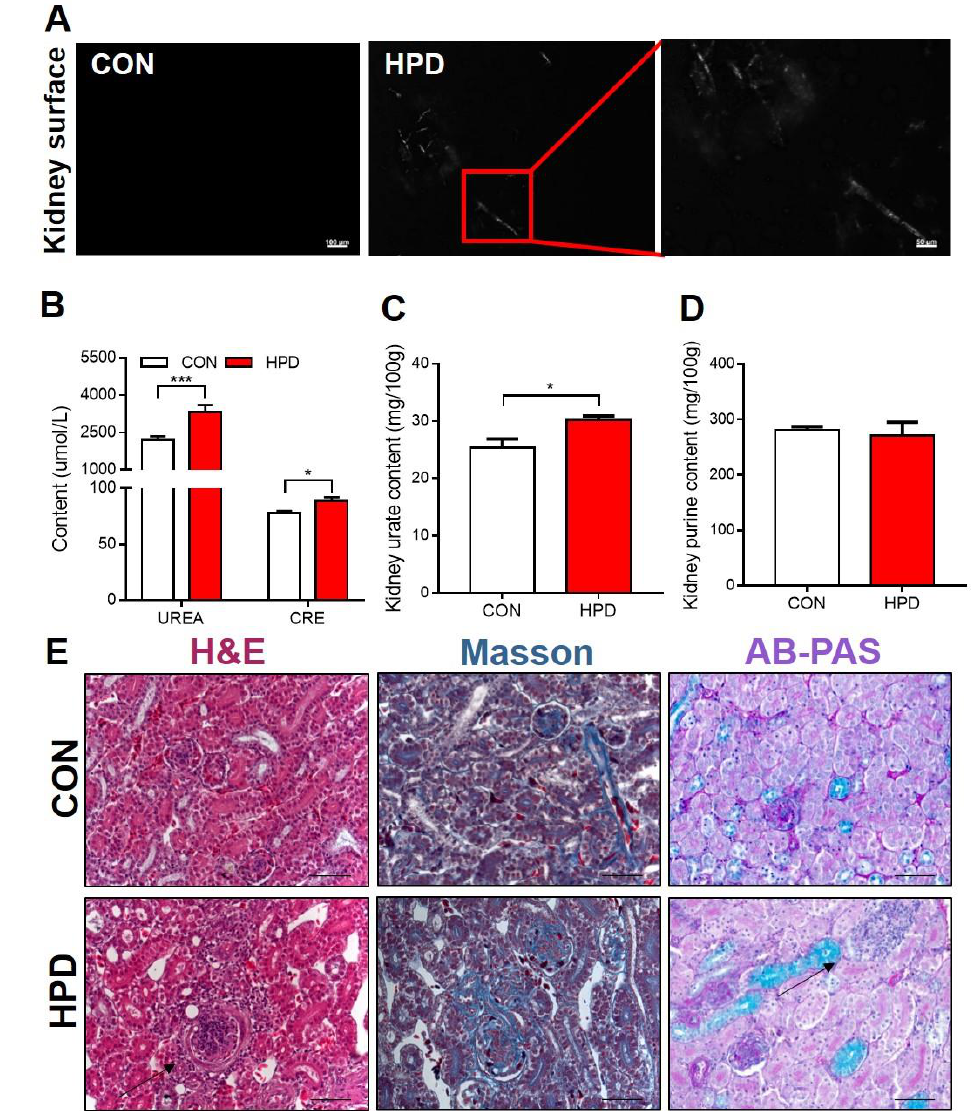
Figure 7. HPD induces renal injury in chickens. ( A ) Representative images of kidney surfaces under polarized light microscopy (scale: 100 µ m and 50 µ m). ( B ) Serum UREA and CRE content. ( C ) Kidney urate and ( D ) total purine content. ( E ) H&E, Masson, and Alcian Blue Periodic acid Schiff (AB-PAS) staining of kidney (scale: 50 μm) . Arrows denote lesions in the kidney. Values are presented as the mean ± SEM. Differences were assessed by non-parametric t test followed by Mann – Whitney test and denoted as follows: * p < 0.05 and *** p < 0.001 compared with CON.